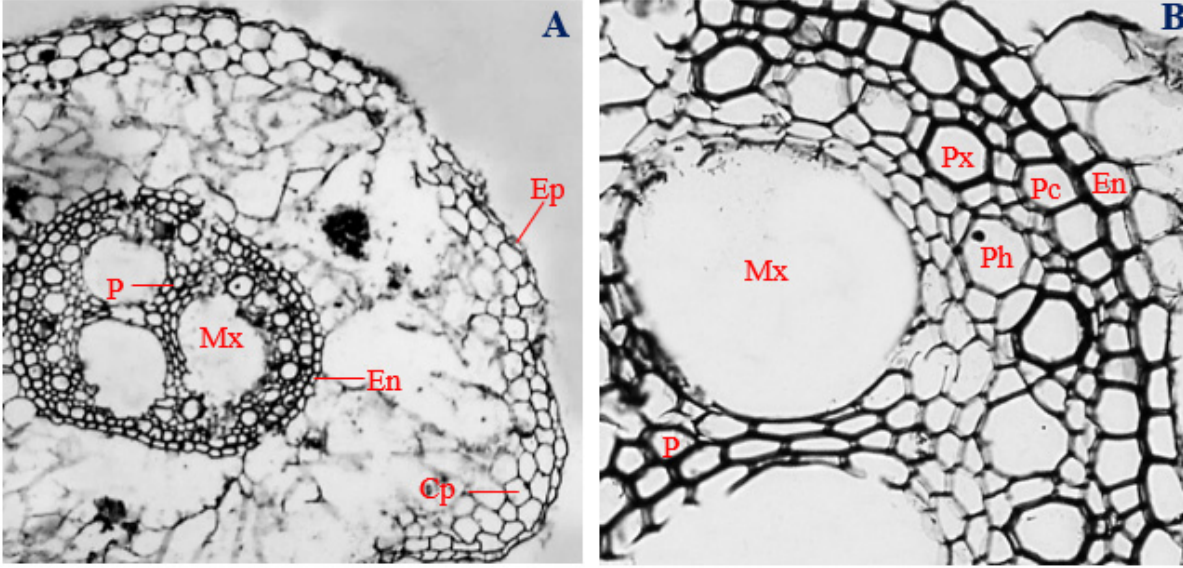
outer regions of the cortex (Figure 1A,B).